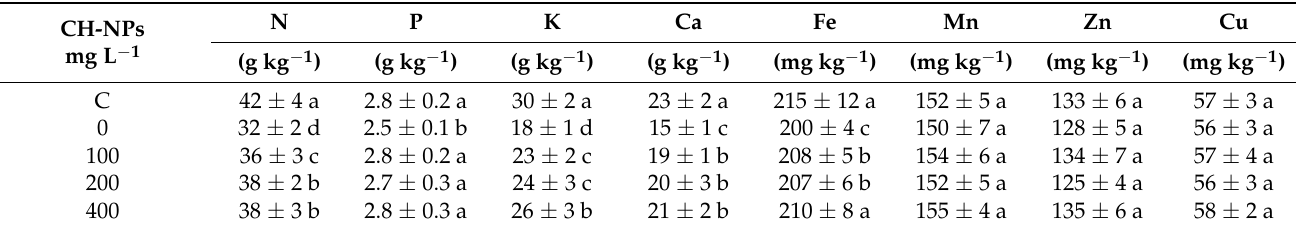
Table 1. Effect of chitosan nanoparticles (CH-NPs) on the elemental composition of leaves of banana plants exposed to cold stress (5 ◦ C for 72 h).